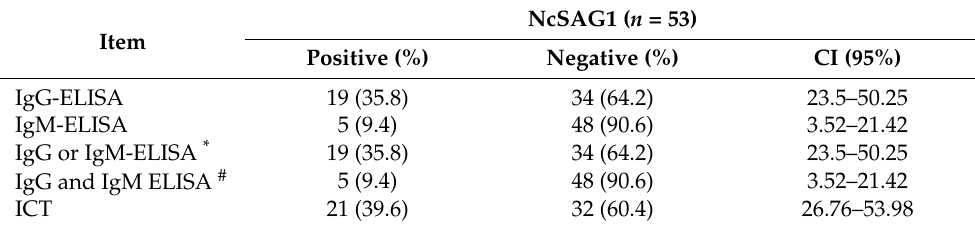
Table 2. Comparison of the reactivity of field cattle sera against the ELISA and ICT using NcSAG1.